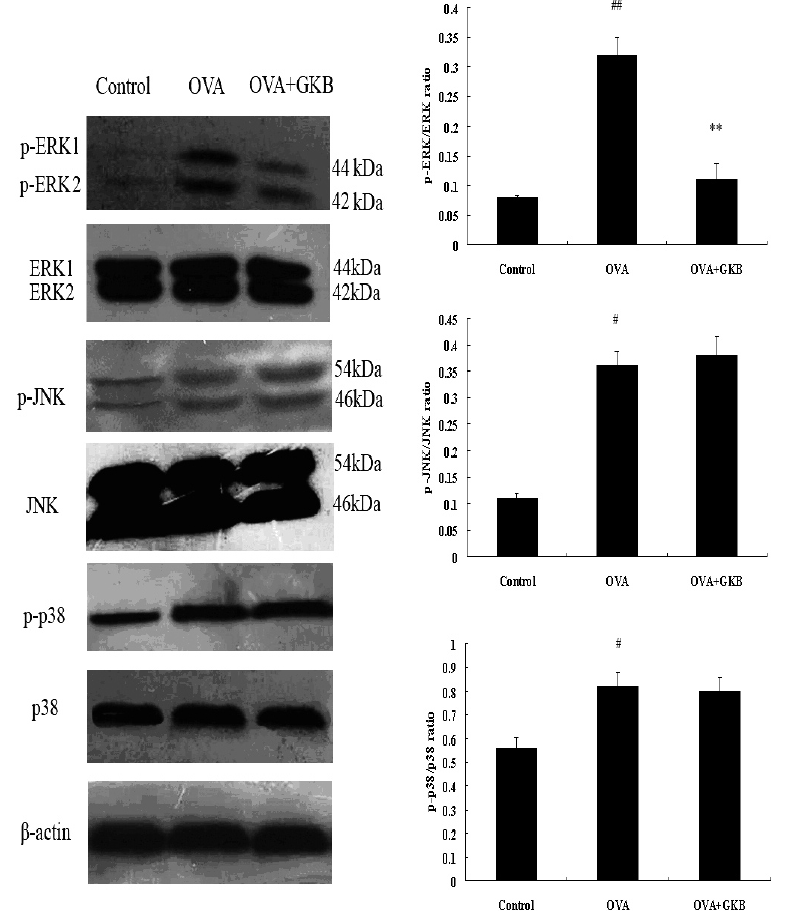
Figure 7. Effects of ginkgolide B on MAPK activation in vivo . Total cellular proteins